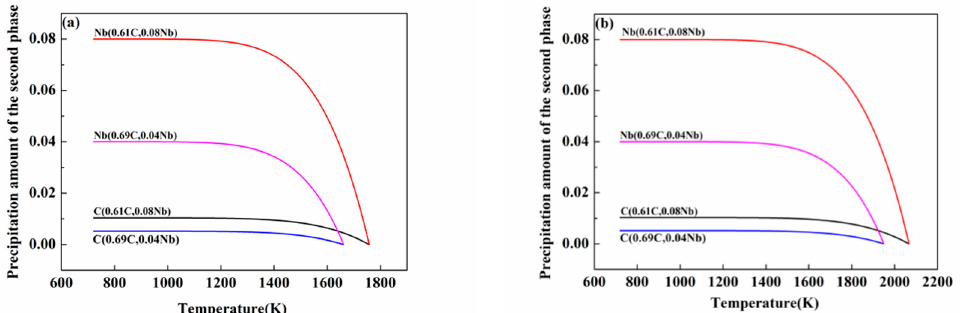
Figure 7. Temperature dependence of precipitation amount of second phase (NbC) in different niobium contents: ( a ) is the result of statistical analysis and ( b ) is the result of phase analysis.